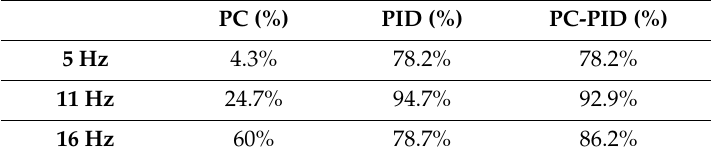
Table 2. Comparison of the vibration deduction of different control methods in the frequency domain.